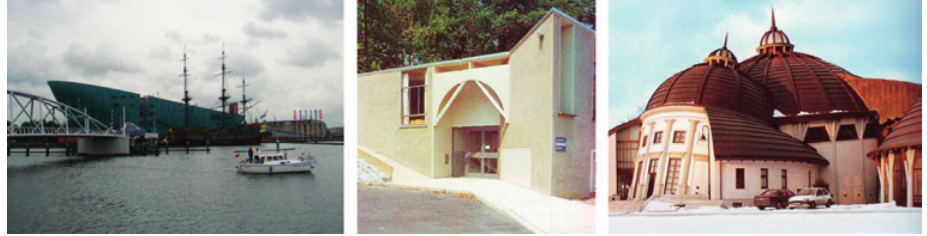
Fig. 26. Renzo Piano. Fig. 27. Robert Venturi. Fig. 28. Imre